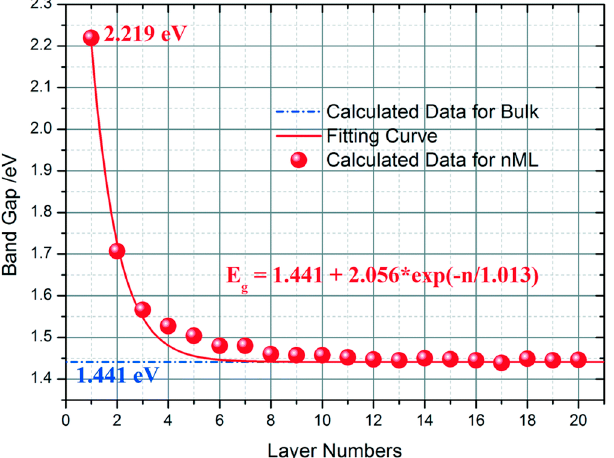
Figure 4. The bandgap of 2H-MoS 2 nanosheets with respect to the layer number; the dot-dashed line represents the corresponding value for the bulk. The figure is reprinted with permission from Ref. [74]. Copyright Royal Society of Chemistry. (2019).